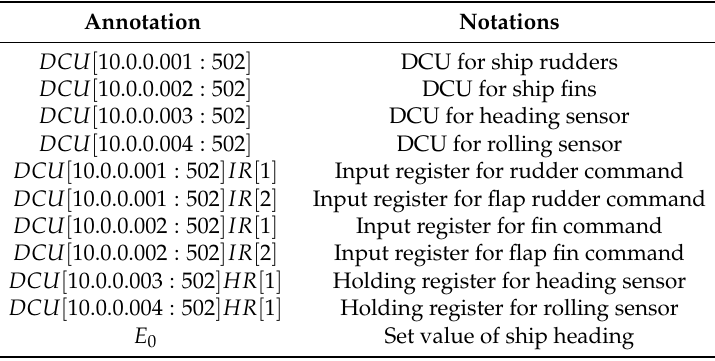
Table 3. Notations of